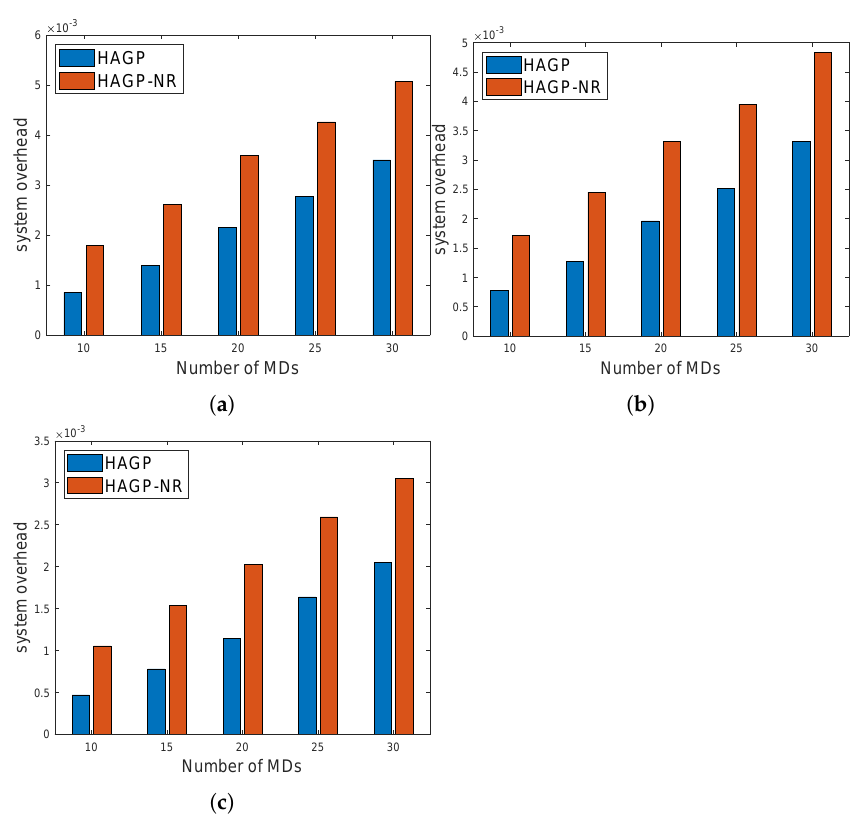
Figure 7. Comparison of HAGP and HAGP-NR. ( a ) λ t = 0.8; (B) λ t = 0.5; ( c ) λ t =